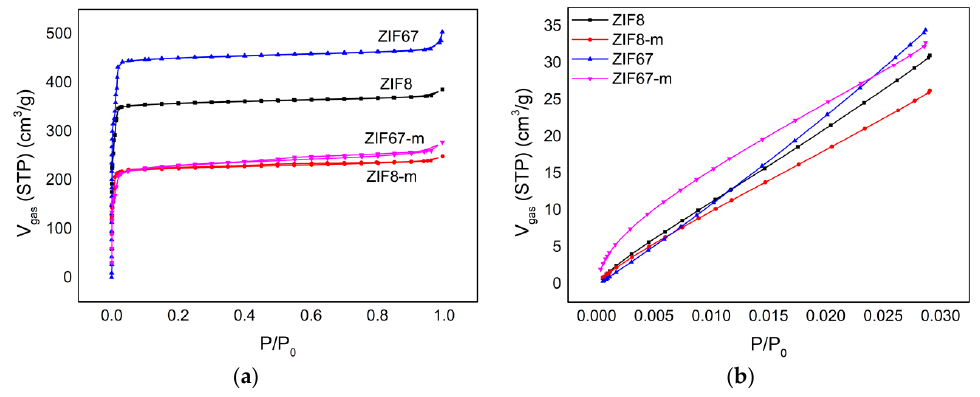
Figure 2. Adsorption isotherm of the four catalysts. ( a ) N 2 at –196 °C; ( b ) CO 2 at 0 °C. Table 1. Textural properties of the four catalysts obtained from N 2 adsorption.